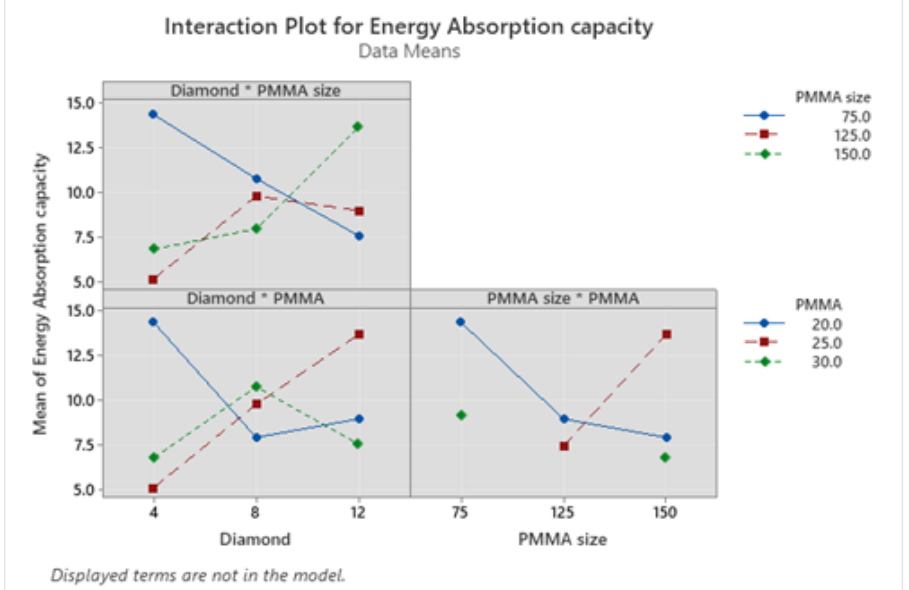
Figure 12. Interaction plots for energy absorption